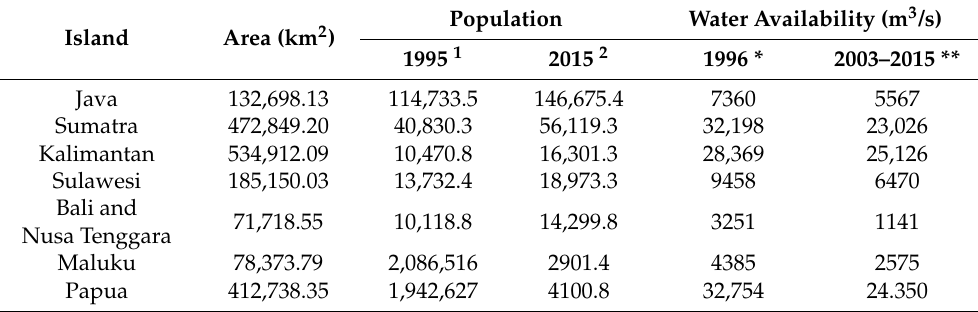
Table 1. Surface Water Availability on Major Islands in Indonesia in 1996 and 2003–2015. Island Area (km 2